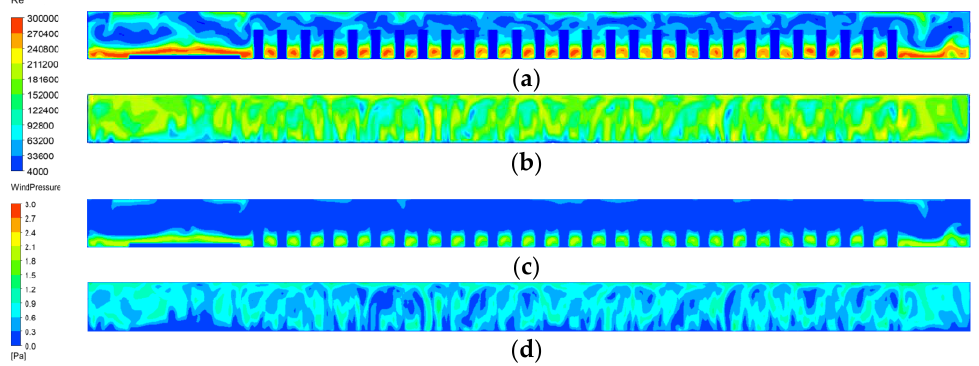
Figure 8. Wind pressure ventilation characteristics in the high-altitude area of: ( a ) x = 4000 mm, Re; ( b ) x = 600 mm, Re; ( c ) x = 4000 mm, wind pressure; ( d ) x = 600 mm, wind pressure.